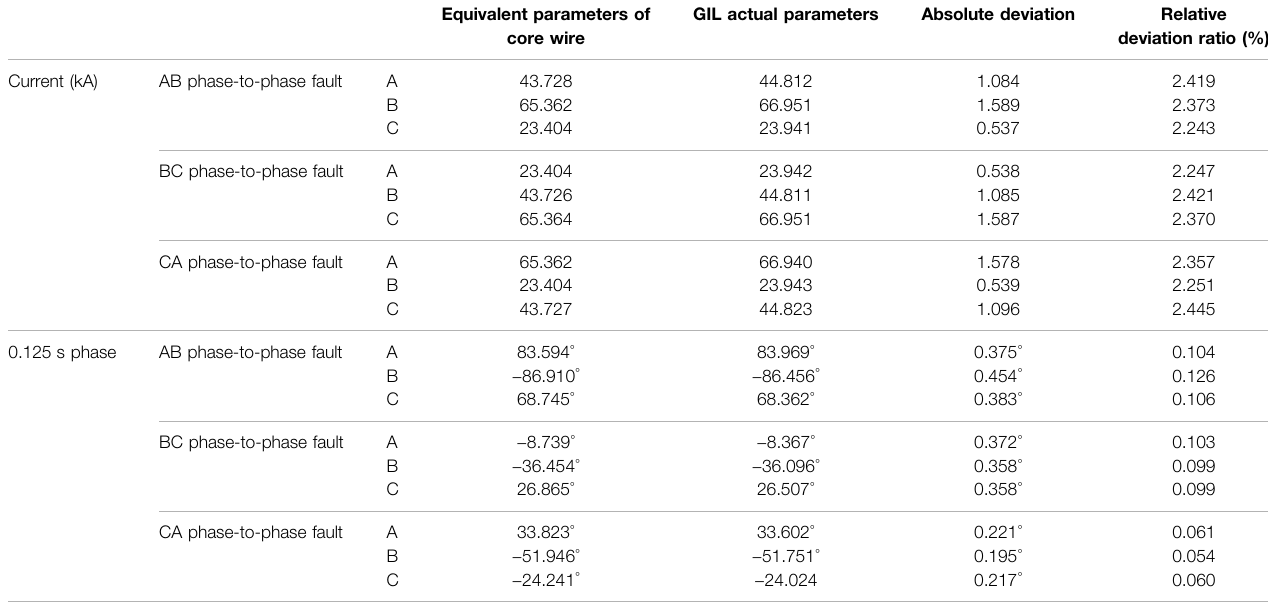
TABLE6| Comparisontableofthethree-phasecurrentsontheNsidebetweentheequivalentparametermodelofthecorewireandtheactualGILparametermodelincase of phase-to-phase faults.